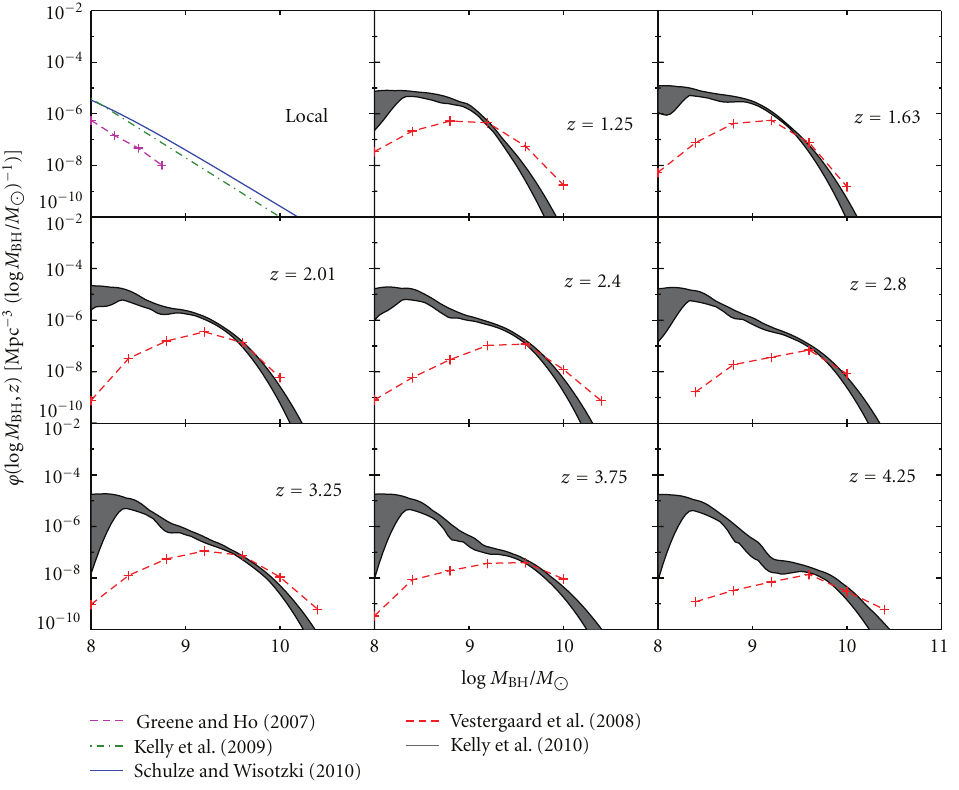
Figure 5: Broad-line AGN BHMFs at a variety of redshifts. Shown are the local BHMF estimated by Greene and Ho [118] (dashed magenta line), Kelly et al. [46] (dot-dashed green line), and Schulze and Wisotzki [121] (solid blue line). Also shown are the z > 1 BHMFs estimated by Vestergaard et al. [119] (dashed red line) and Kelly et al. [115] (shaded region), where the shaded region for the Kelly et al. [115] estimate defines an approximate 95% confidence region. The BHMFs estimated by Greene and Ho [118] and Vestergaard et al. [119] are flux-limited BHMFs, as they did not fully correct for incompleteness in M BH